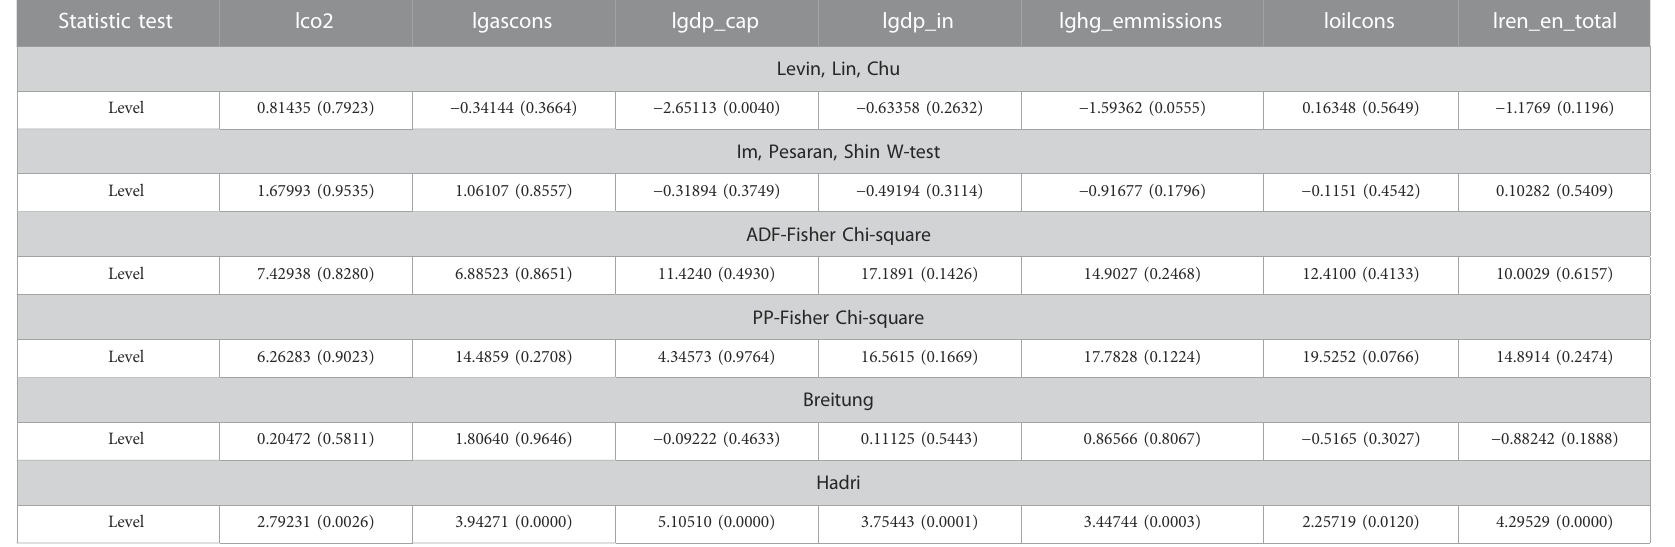
TABLE 5 Panel unit root tests for G7